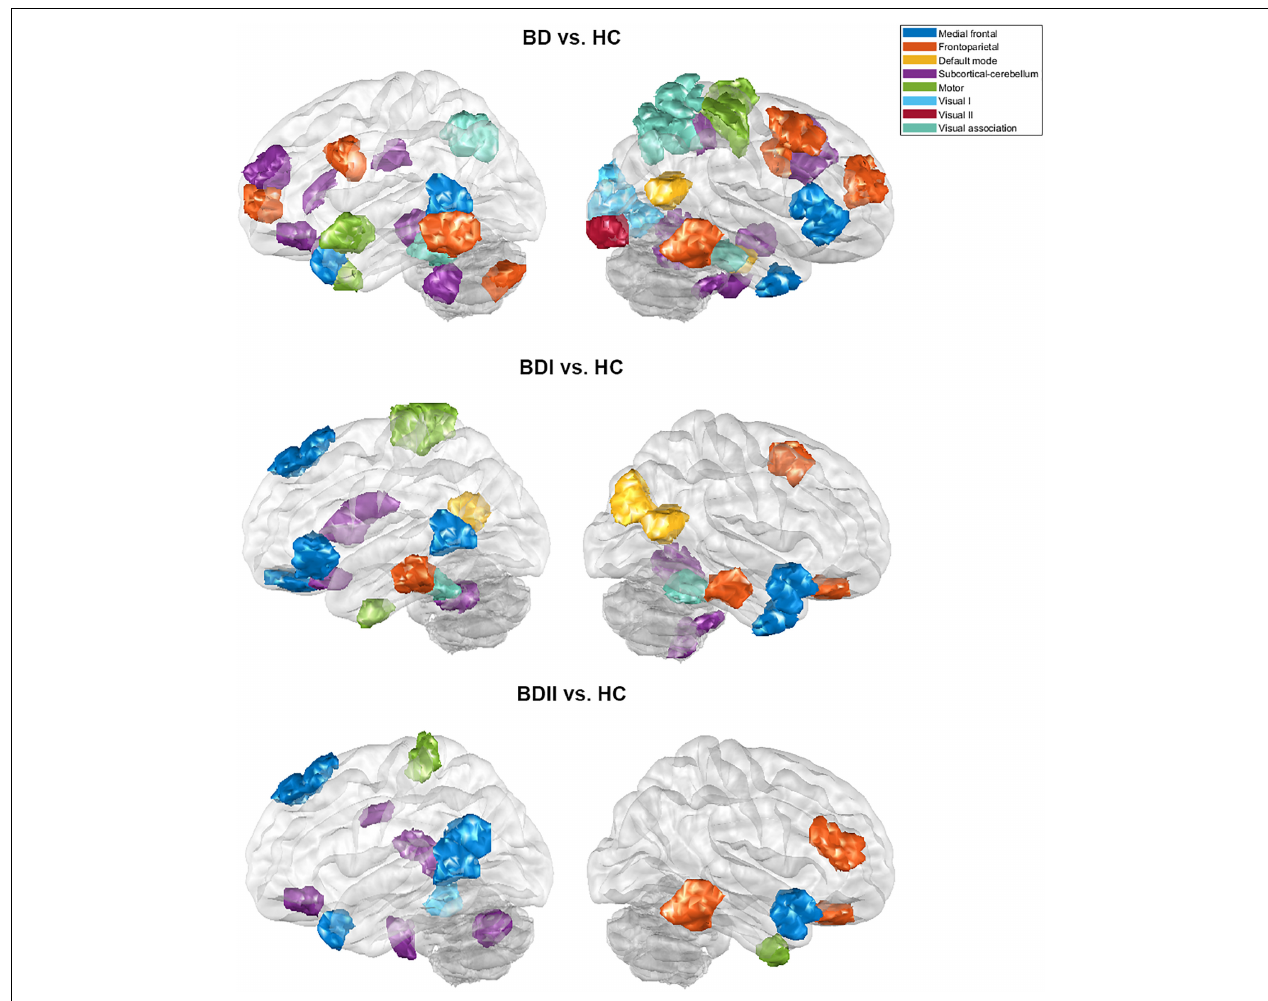
FIGURE 3 | The major features of the classification for the bipolar disorder and healthy control groups, the bipolar I disorder and healthy controls groups, and the bipolar II disorder and healthy controls groups after the 10 times process of minimum redundancy/maximum relevance selection during the outer loop of the nested cross-validation illustrated on the glass